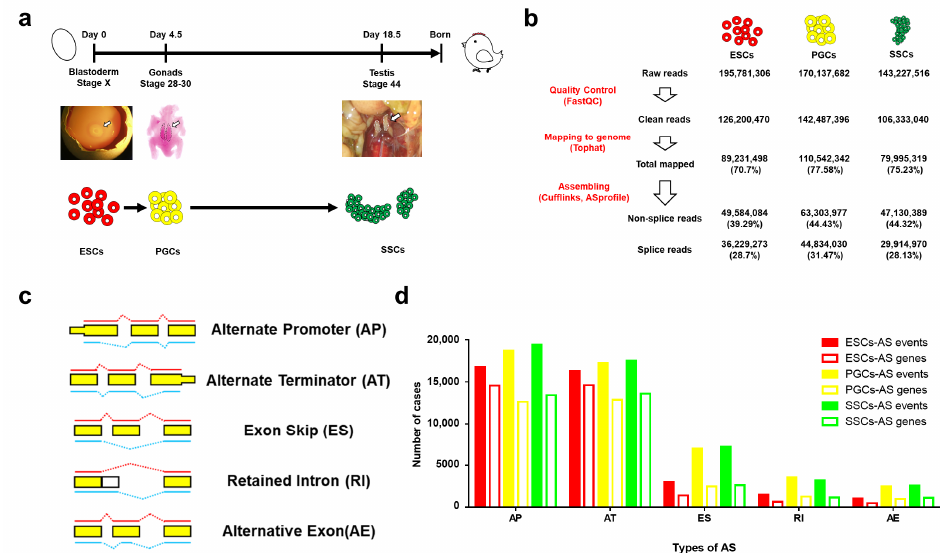
Figure 1. AS events during chicken male germ cell differentiation. ( a ) ESCs were isolated from the blastoderm of fertile eggs at E0 (HH stage X). gPGCs were isolated from chicken gonads at E4.5 (HH stage 28–30), and SSCs were isolated from chicken testis at E18.5 (HH stage 44). ( b ) The overview of RNA-seq data analysis pipeline. ( c ) Representative model for five types of AS events, including alternative 5′ splice site (A5′), alternative 3′ splice site (A3′), exon skip (ES), retained intron (RI), and alternative exon (AE). ( d ) Numbers of AS events and involved genes during male chicken germ cell differentiation. Table 2. The identification of AS events in chicken ESCs, gPGCs, and SSCs.